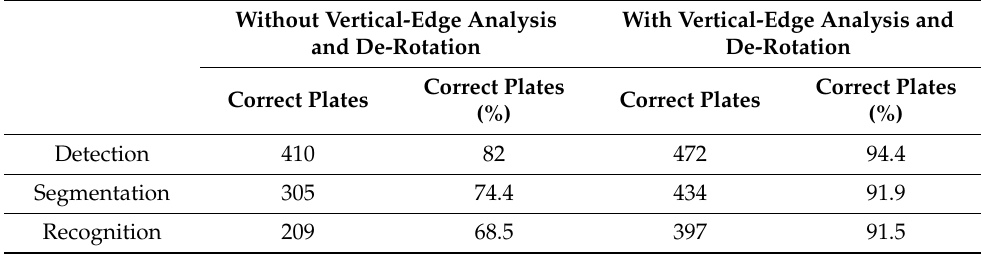
Table 3. A component-level performance comparison between the old and improved ALPR systems using the full dataset (500 images).